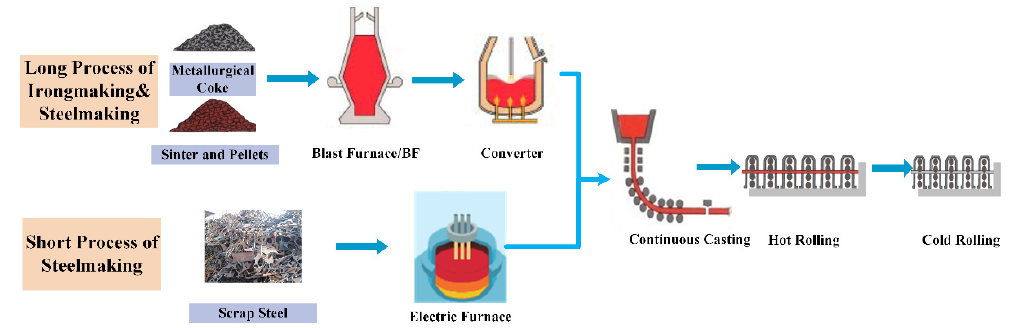
Figure 1. Schematic diagram of different processes in steel industry.